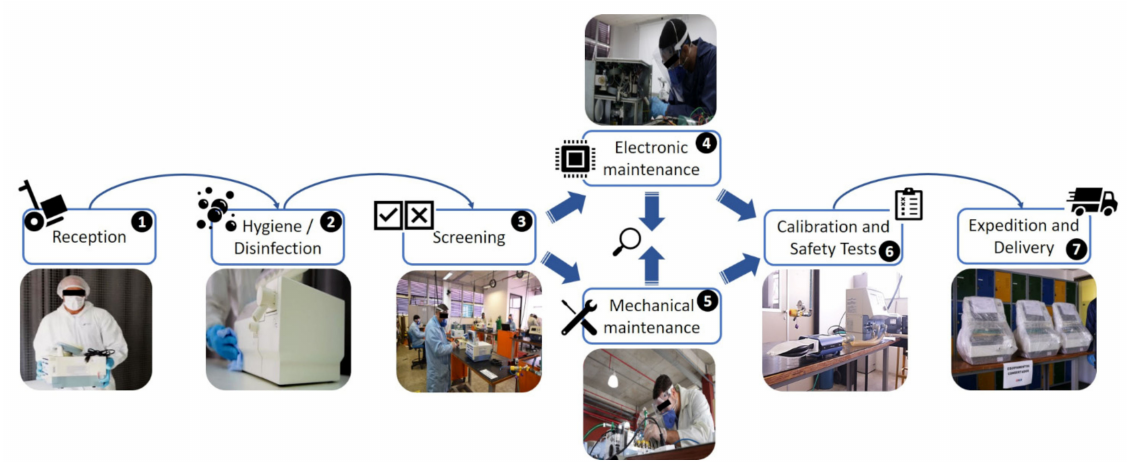
Figure 5. Flowchart showing all steps to complete ventilator repair, from reception to expedition and return to original healthcare unit. Maintenance line at Reference Unit.